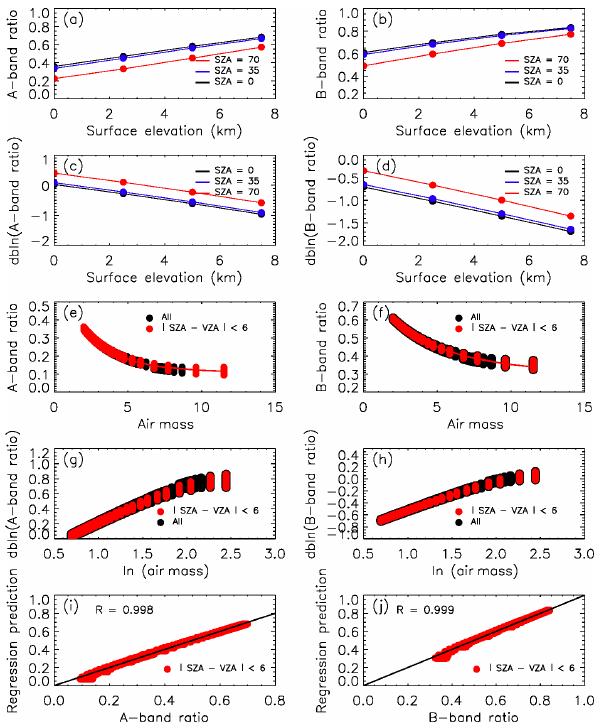
Figure 1. Relationships between model simulations of clear-sky A- band (left column) and B-band (right column) ratios with surface elevation and relative air mass. (a, b) O 2 band ratios as a function of surface elevation; (c, d) double logarithm of O 2 band ratios versus surface elevation; (e, f) O 2 band ratios as a function of total relative air mass; (g, h) double logarithm of O 2 band ratios versus logarithm of total relative air mass; (i, j) scatter plot of fitted thresholds and O 2 band ratios. The red points in panels (e) – (j) show the simulations when the difference between θ s and θ v is smaller than 6 ◦ to mimic the EPIC Sun–view geometry. The fitted thresholds are computed with a multivariable linear regression in which double logarithms of O 2 band ratios are expressed as a function of surface elevation and logarithm of total relative air mass. The simulations use four at- mospheric profiles: midlatitude winter, subarctic summer, subarctic winter, and standard US atmosphere. Surface albedo is set at 0.8 to represent snow and ice surface.